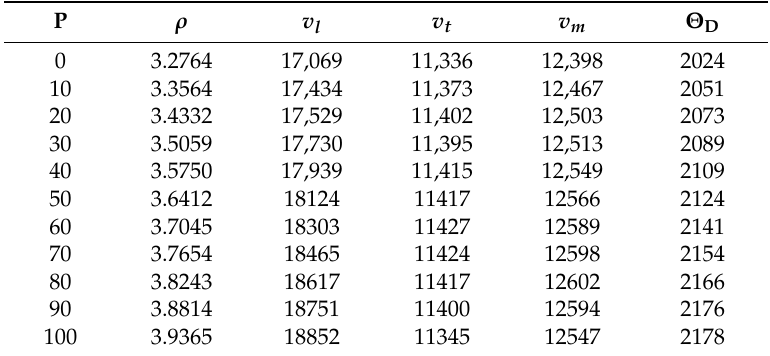
Table 3. The calculated density ( ρ , in g/cm 3 ), the longitudinal, transverse, and mean elastic wave velocity ( v s , v p , v m , in m/s), and the Debye temperature ( Θ D , in K) for I4 –carbon. P ρ v l v t v m Θ D 0